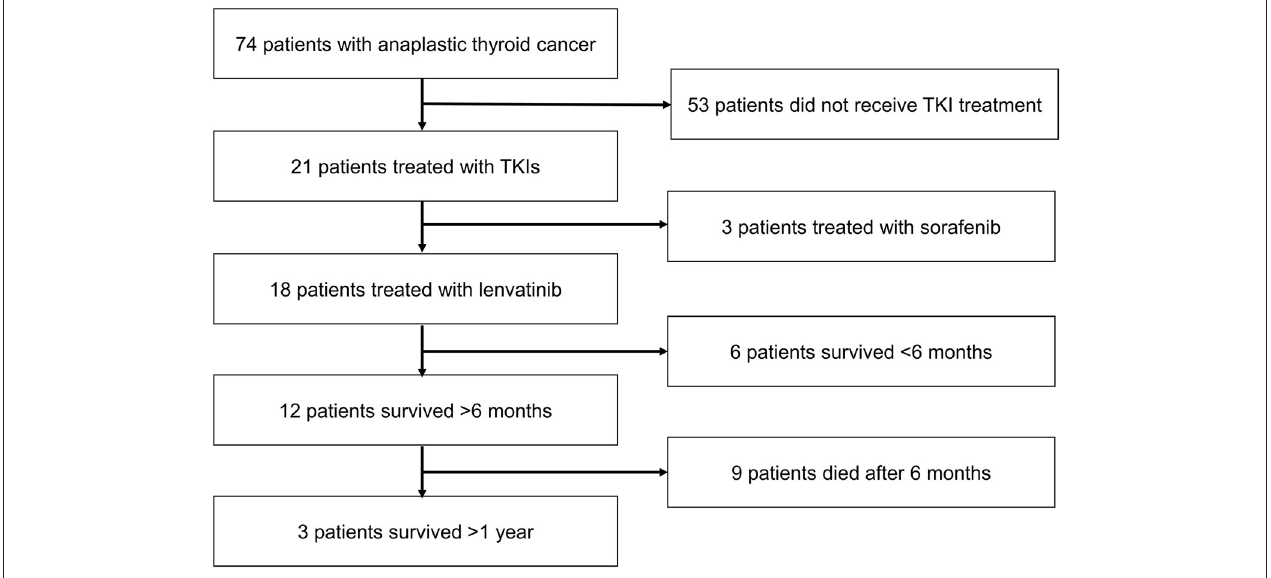
FIGURE 2 | Patient disposition. TKI, tyrosine kinase inhibitor.